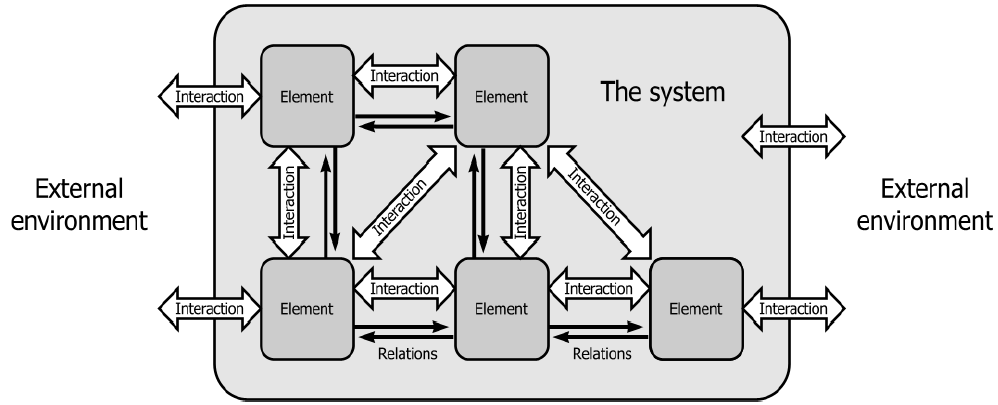
Fig. 1. Scheme of system components (authors’